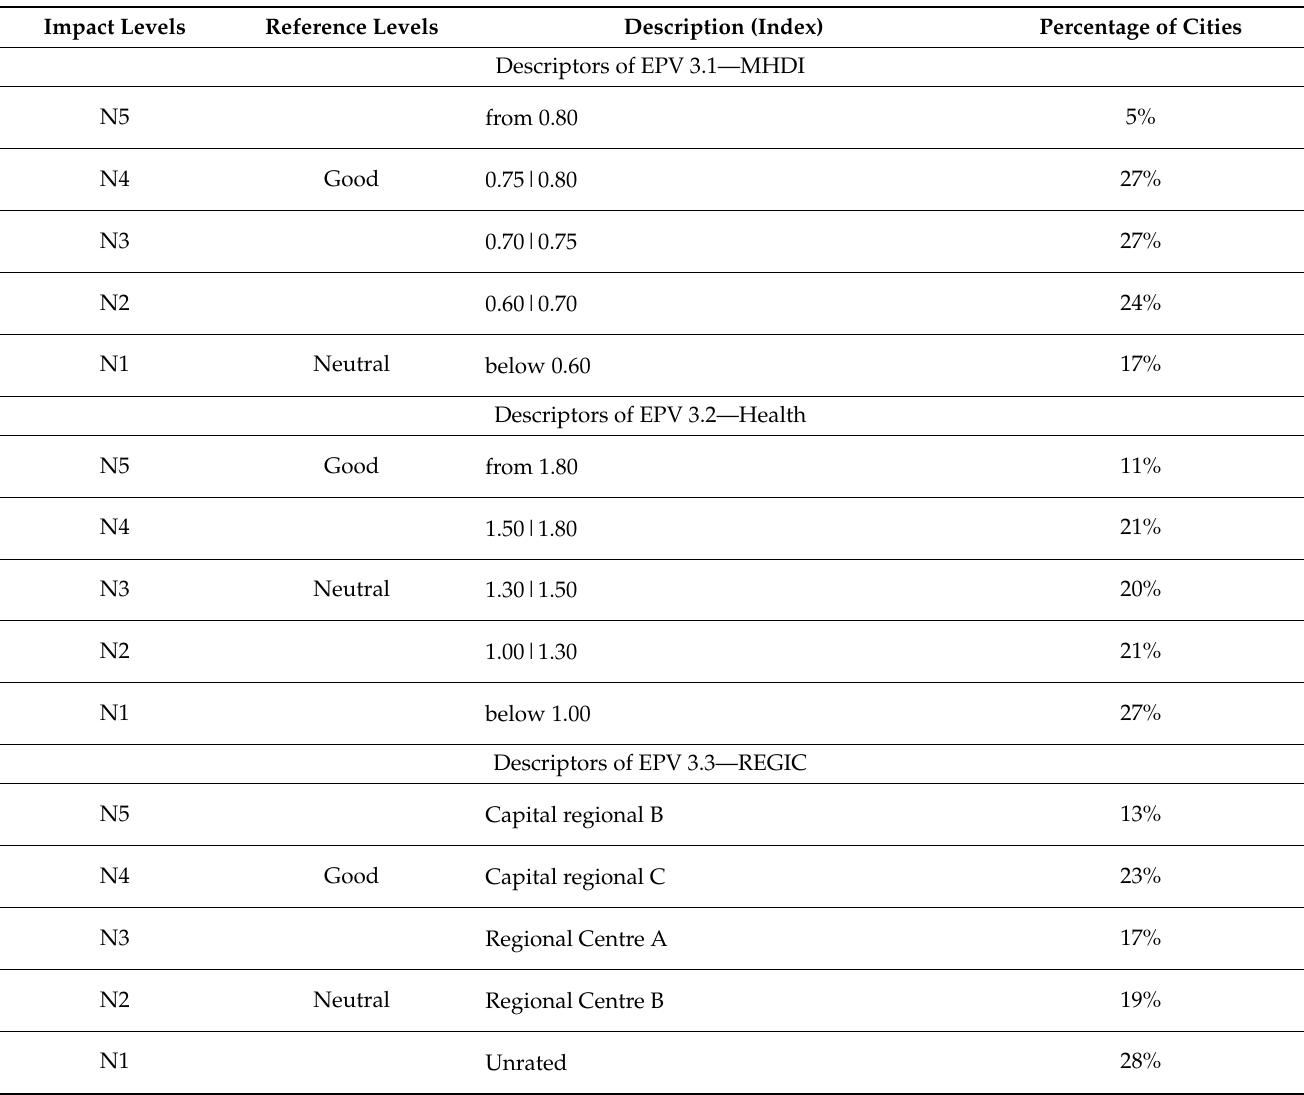
Table 4. Descriptors of FPV 3—social